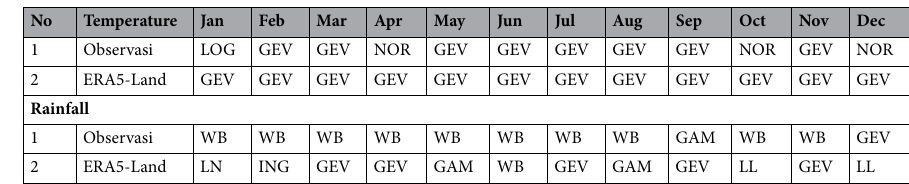
Table 1. Identification of the data distribution of observation temperature and temperature of ERA5-Land and observation rainfall and rainfall of